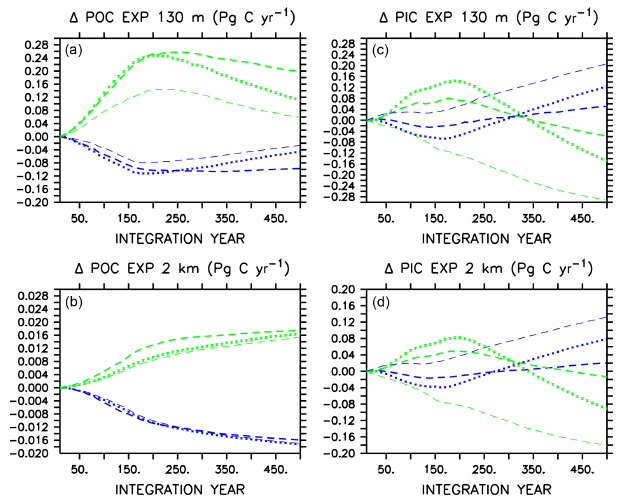
Figure 2. Change in globally integrated annual POC (a, b) and PIC (c, d) export in WARMING icehouse (blue) and COOLING greenhouse (green) experiments. Dotted lines represent the MIXED model, thin dashed lines represent the NOCACO3TR model, and thick dashed lines represent the CAL model.